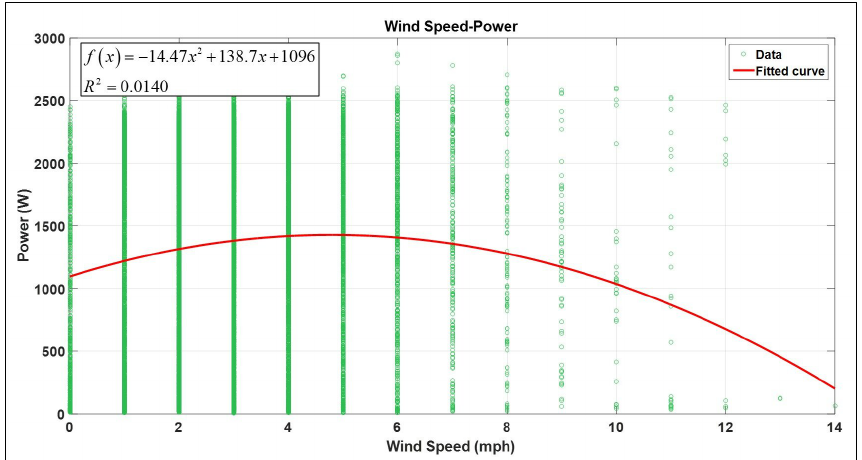
Figure 6. The Power vs. Wind speed of HS.